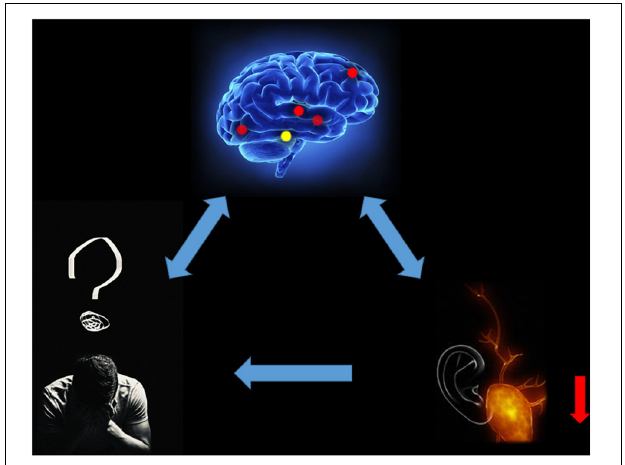
FIGURE 5 | Relationship between MRI images and clinical manifestations in MCI. MCI, mild cognitive